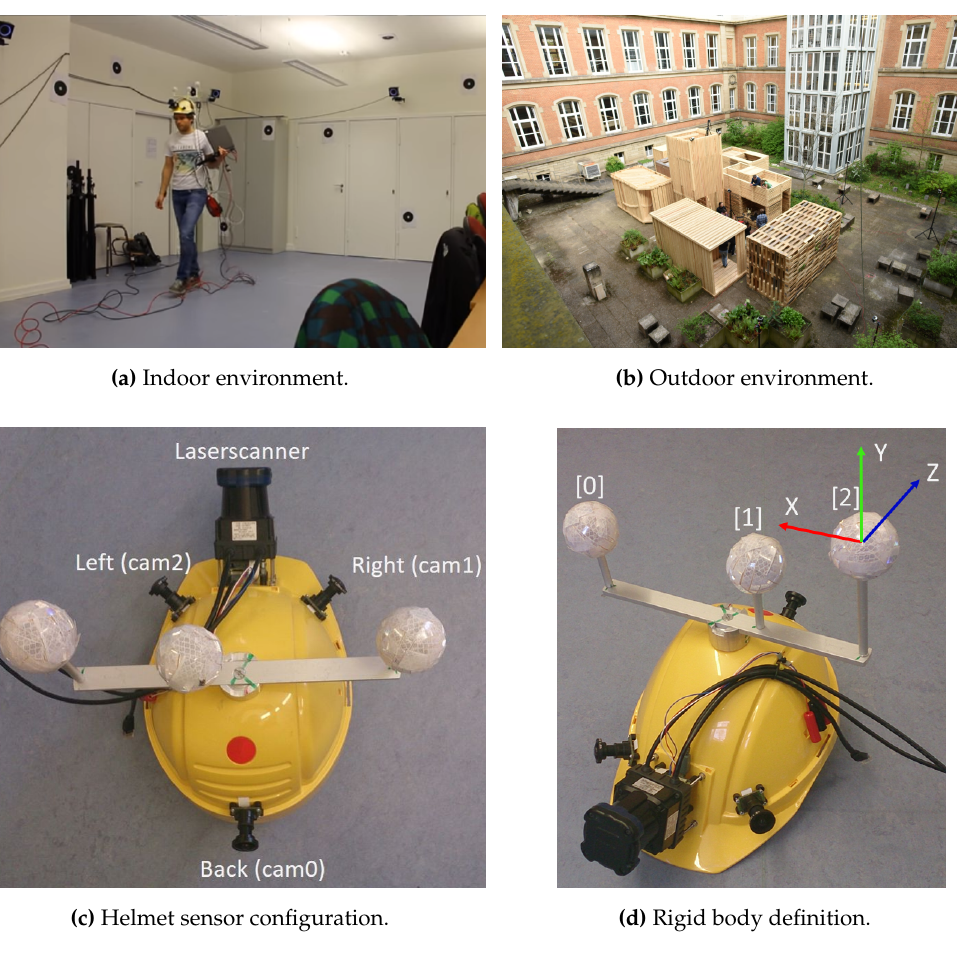
Figure 1. Depicted are the ( a ) indoor and ( b ) outdoor scenes. In ( c , d ) the helmet sensor configuration and the rigid body definition (colored coordinate frame) are pictured. The three reflective rigid body markers (spheres) are enumerated with